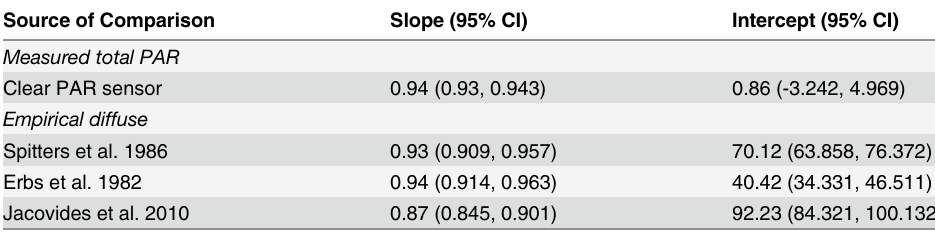
Table 4. Statistical analysis of Deming regression of shadowband measurements against empirically derived and measured